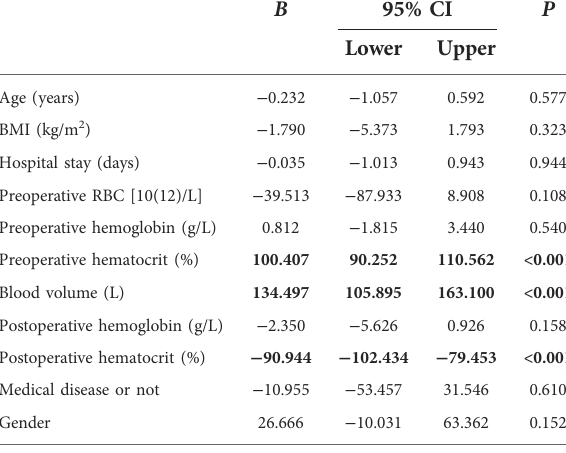
TABLE 4 Multiple regression analysis related to actual blood loss.